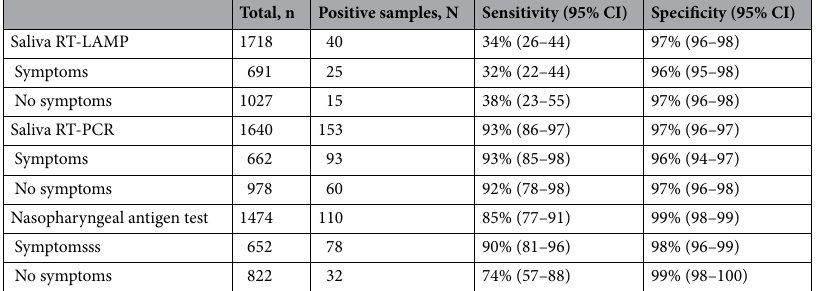
Table 3. Diagnostic accuracy of the saliva RT-LAMP or RT-PCR and the nasopharyngeal antigen test as compared to the reference standard (nasopharyngeal RT-PCR, positivity defined as at least one target gene detected), according to the presence of symptoms in study participants. 95% CI 95% Confidence